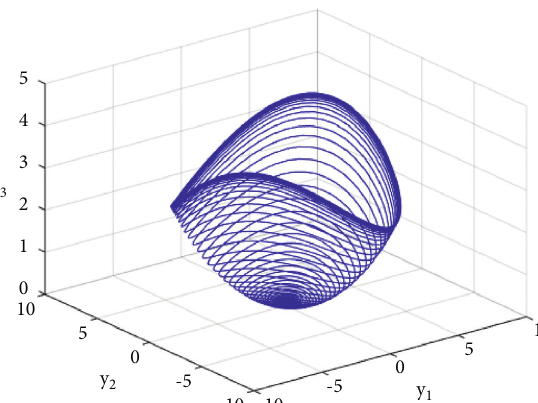
Figure 1: 3D view of the integer-order Matouk’s system (4) with a � 12 ,b � 15 ,c � 7 . 35 , d � − 0 . 85 , h � − 0 .